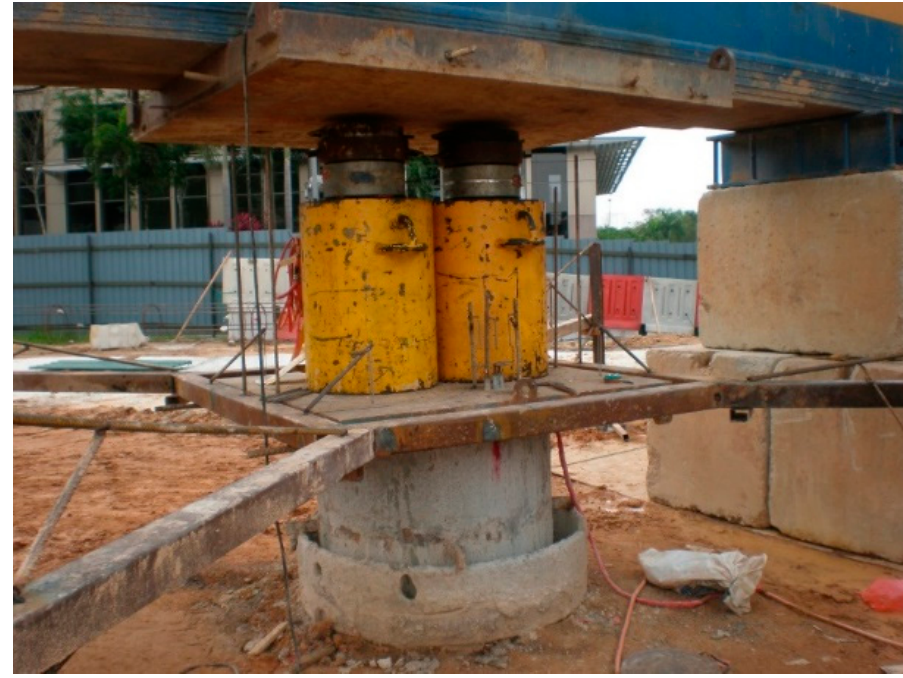
Figure 10. Existing platform in full-scale maintenance of the pile load test.